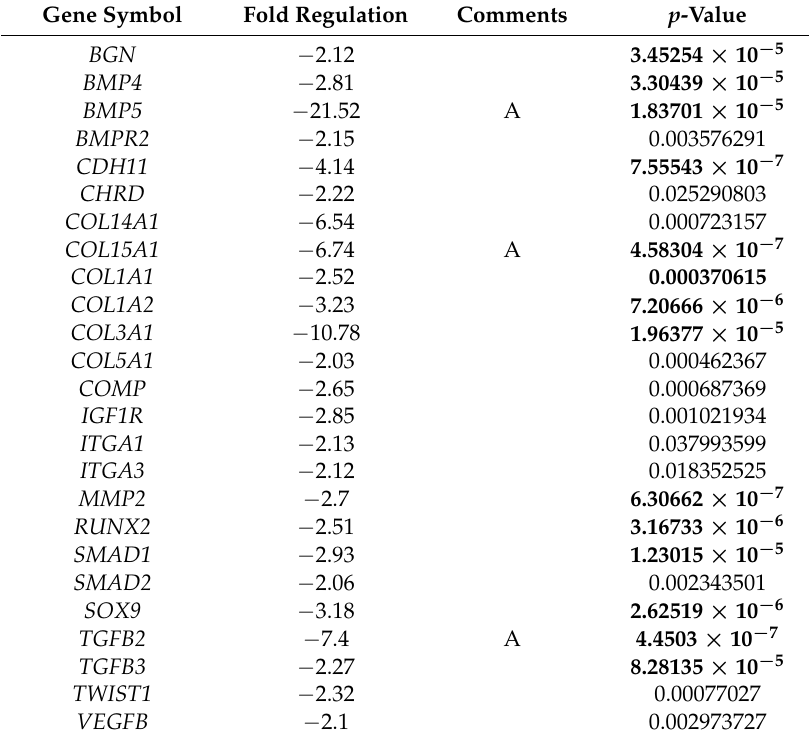
Table 1. Genes down-regulated by CoCl 2 after 24 h by at least a factor of 2 (normalization of C t -values to glyceraldehyde 3-phosphate dehydrogenase (GAPDH)). The significance level was adjusted for multiple testing to 0.0006 (bold p -values are significant). A = in either the control or the test sample, the average C t is high (>30 cycles).